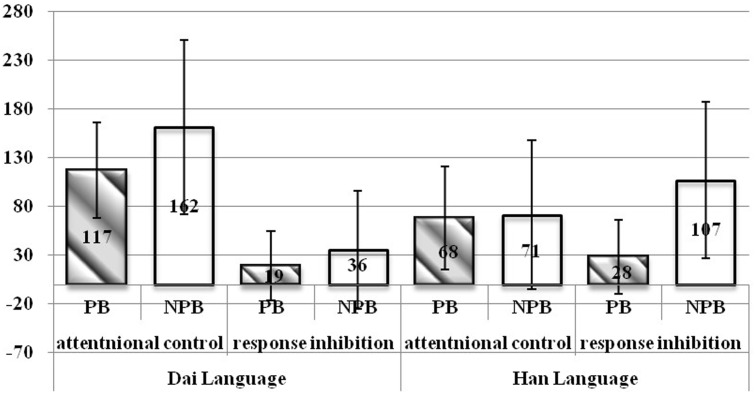
Mean effect of different inhibitory control stages. Effect of attention control = RTSI–RTSC and effect of response inhibition = RTRI–RTRC (Kornblum and Lee, 1995). SI, stimulus inconsistent; SC, stimulus consistent; RI, response inconsistent; and RC, response consistent.